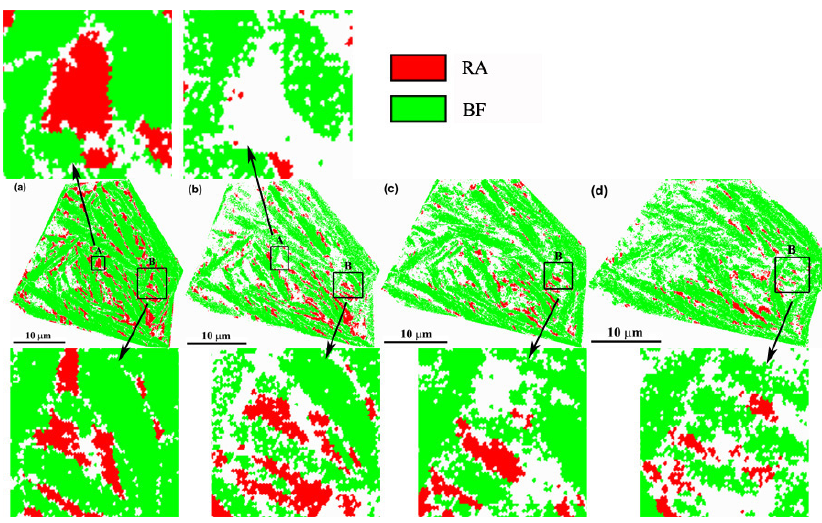
Figure 4. Phase maps of specimens with different strains: ( a ) 0, ( b ) 0.025, ( c ) 0.054, and ( d ) 0.104. The white areas are the areas without index.